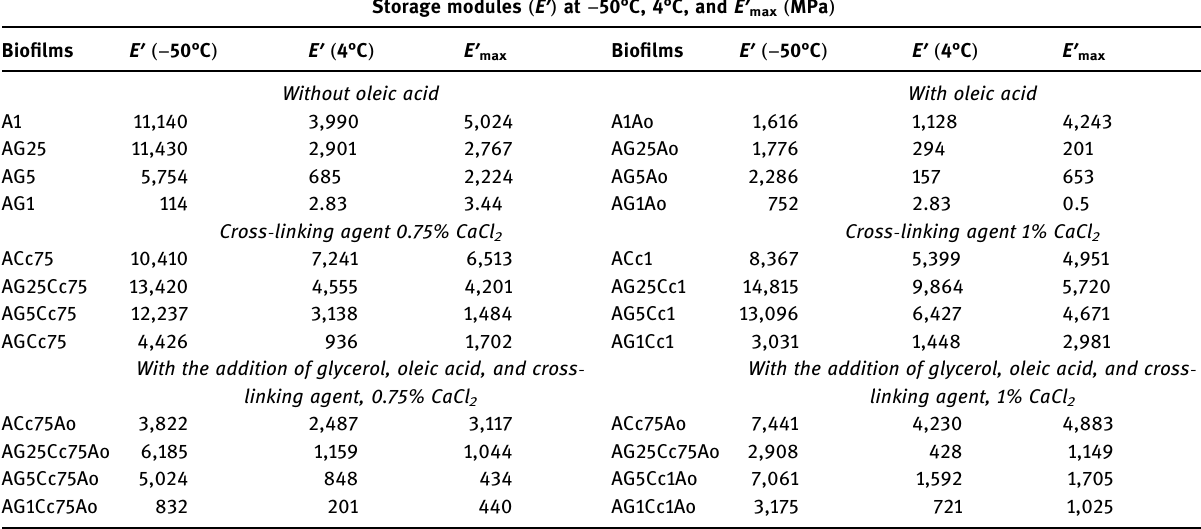
Table 2: Evaluation of the storage module ( E ′ ) of the alginate/glycerol bio fi lms vs the addition of oleic acid ( hydrophilicity controller ) and CaCl 2 ( cross - linking agent